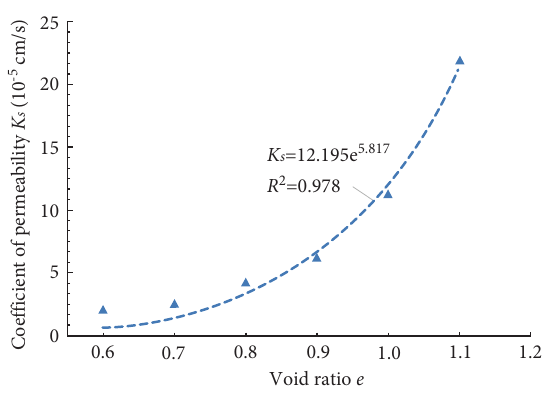
Figure 8: Saturated hydraulic conductivities at different void